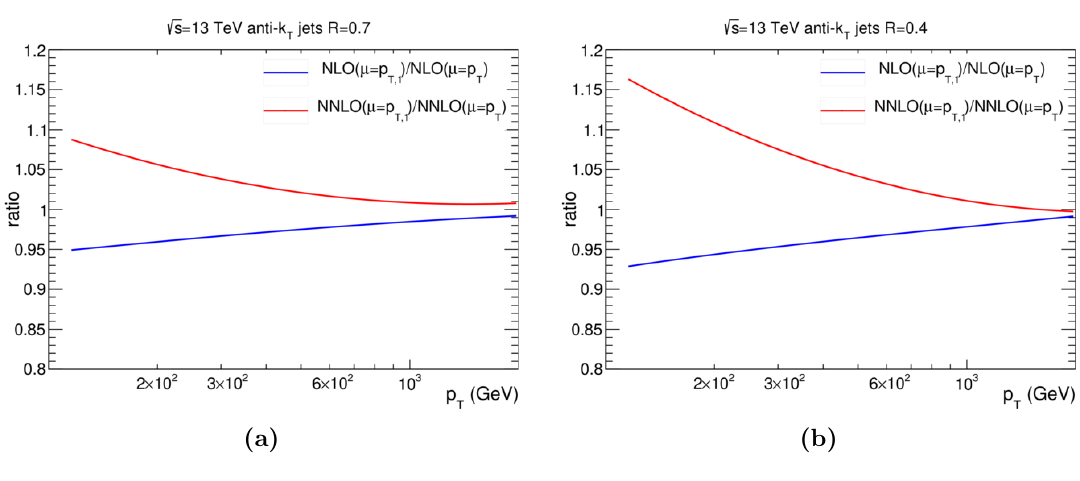
Figure 6 . Ratio between predictions for the single jet inclusive distribution integrated over rapidity obtained with (cid:22) = p T ; 1 and (cid:22) = p T at NLO (blue) and NNLO (red) for di(cid:11)erent jet resolution: (a) R = 0 : 7; (b) R = 0 :